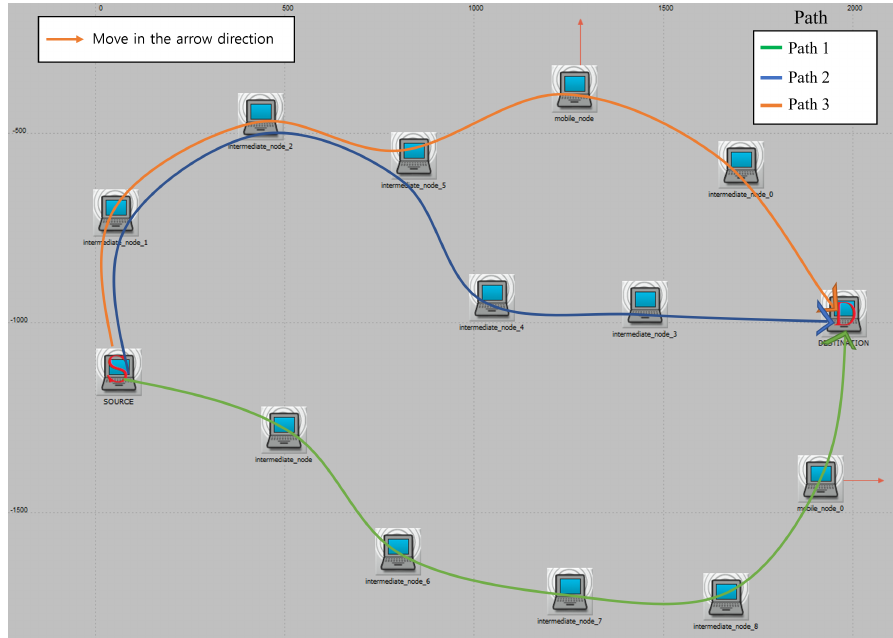
Figure 16. Network configuration for the simulation study.